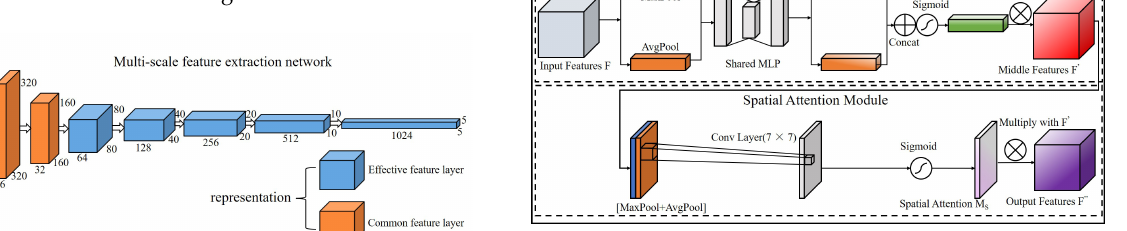
Fig. 4. The structure of improved backbone feature extraction network.